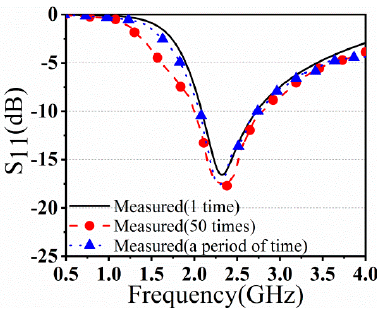
Figure 12. Comparison of measured performance of fatigue tests.